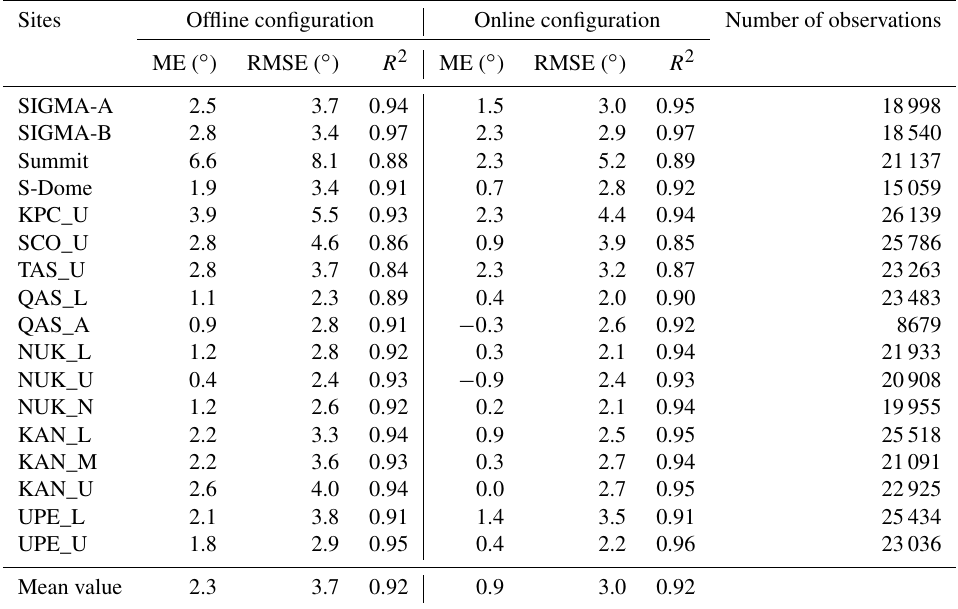
Table 3. Model performance in simulating hourly 2m air temperature at each AWS on the GrIS (locations in Fig. 1). ME is mean error (average of the difference between simulated and observed values), RMSE is root mean square error, and R 2 is coefficient of determination.